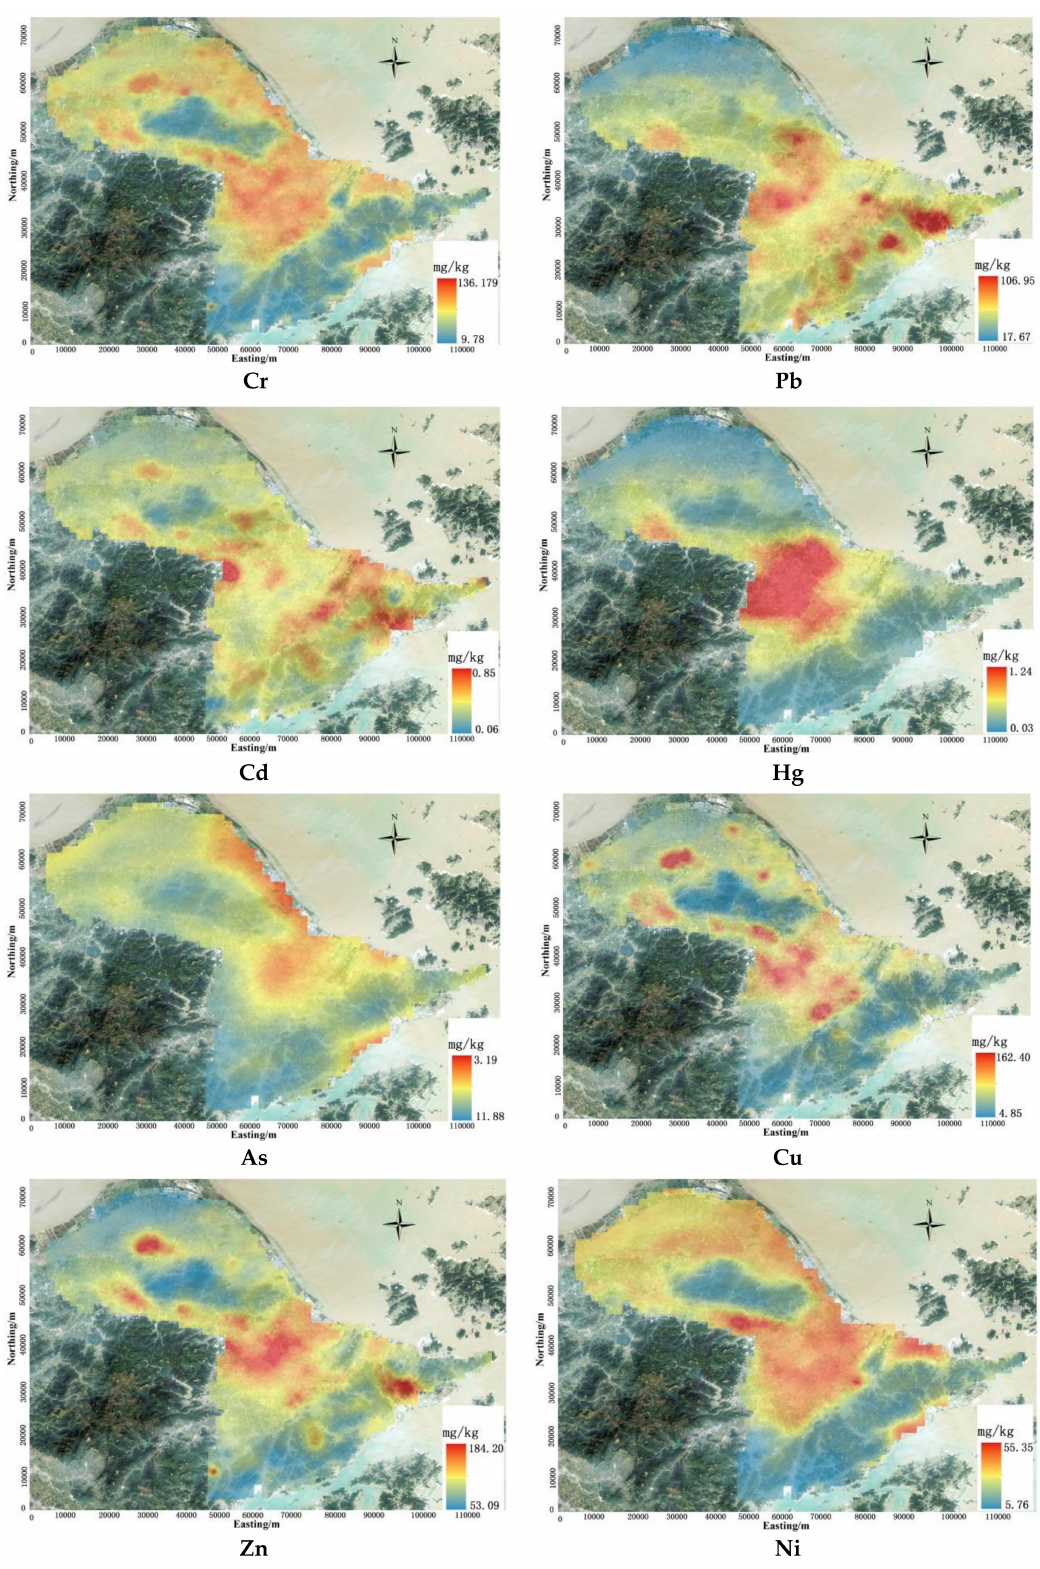
Figure 2. Spatial distribution of heavy metal